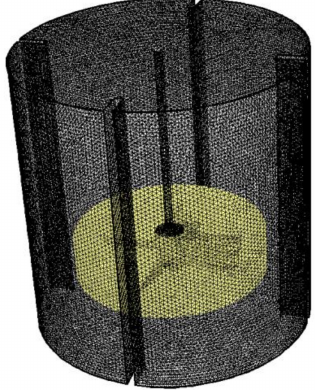
Figure 3. Computational